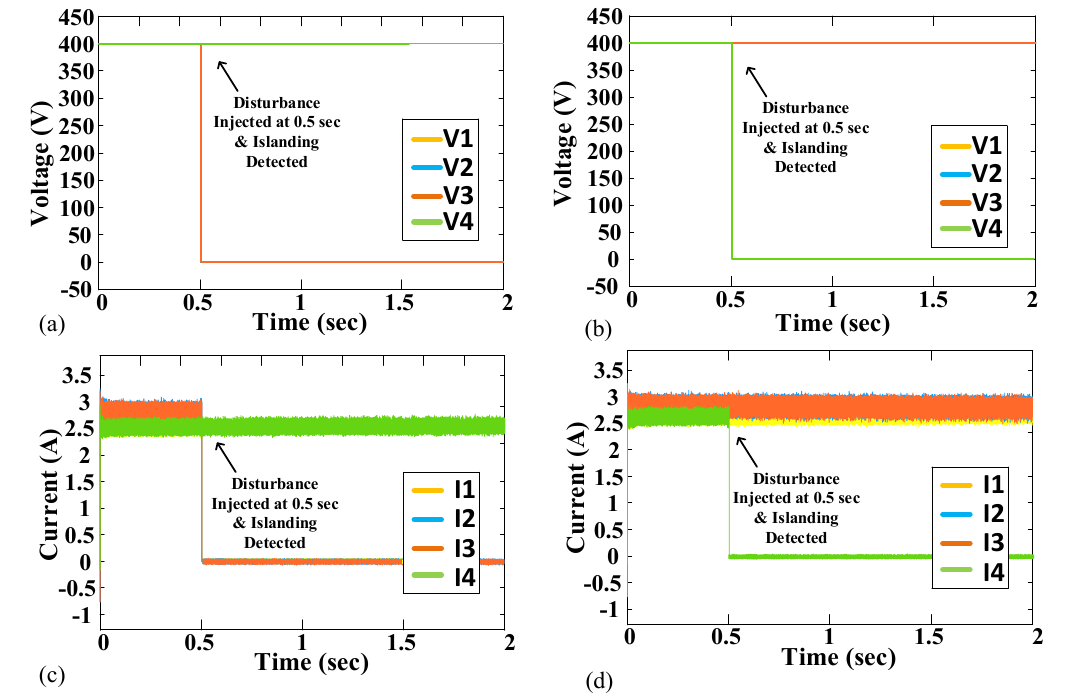
Figure 9. DC MG nodes look-up table: ( a ) Connected Nodes’ Voltage, ( b ) Disconnected Node 4 Voltage, ( c ) Connected Nodes’ Current, ( d ) Disconnected Node 4 Voltages. Table 4. Look-up table values for simulation results for electrical connectivity.